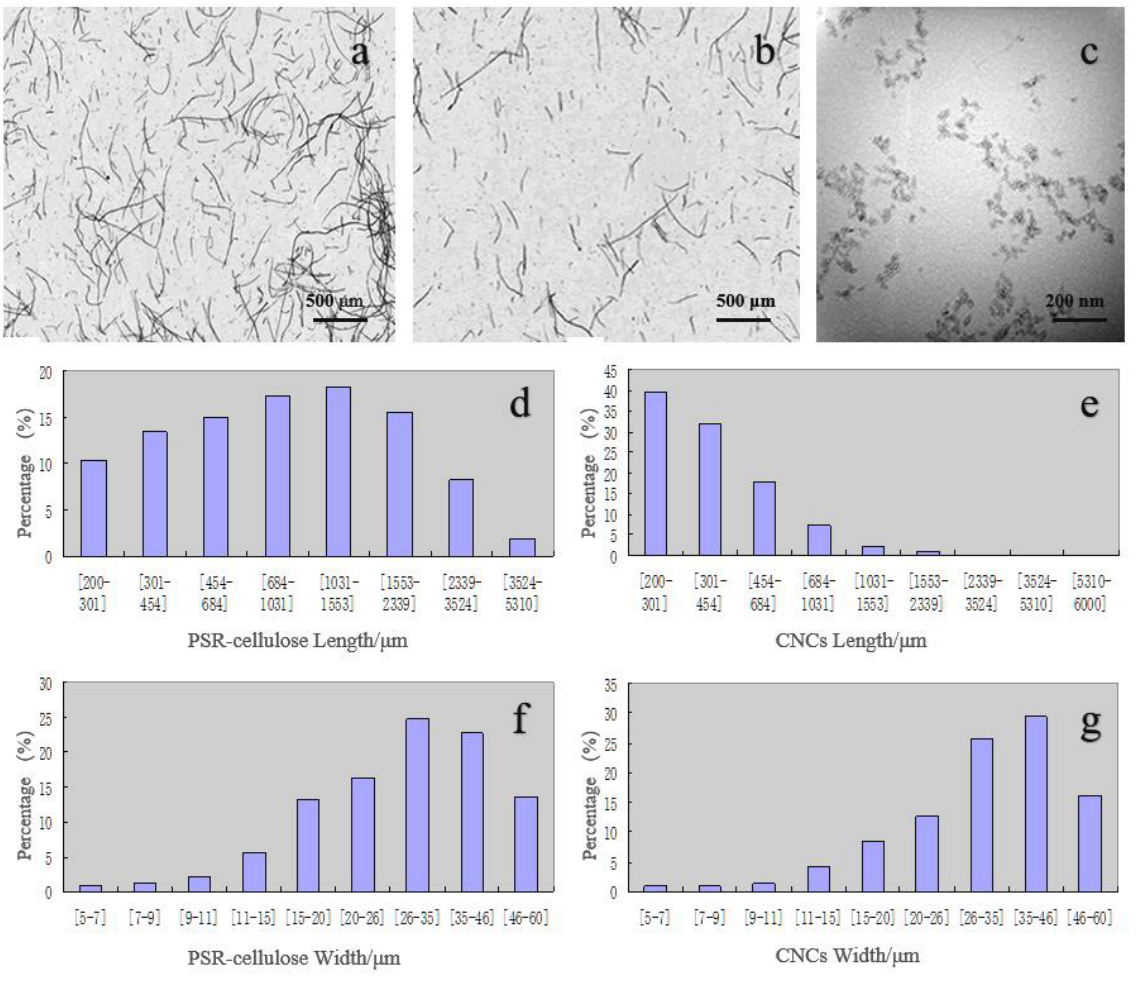
Figure 2. Fiber analyzer micrograph of PSR-cellulose ( a ) and CNCs ( b ); TEM micrograph of CNCs ( c ); length distribution chart of PSR-cellulose ( d ) and CNCs ( e ); width distribution chart of PSR- cellulose ( f ) and CNCs ( g ).